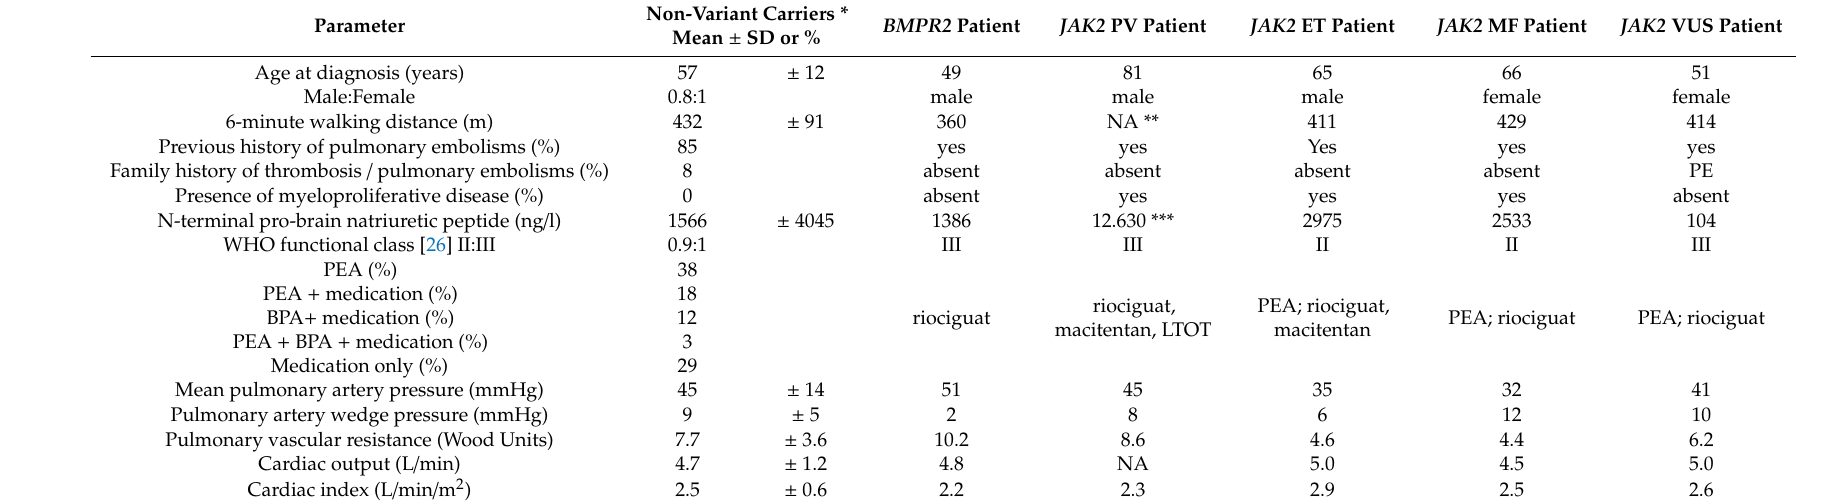
Table 3. Clinical characteristics of non-variant and variant